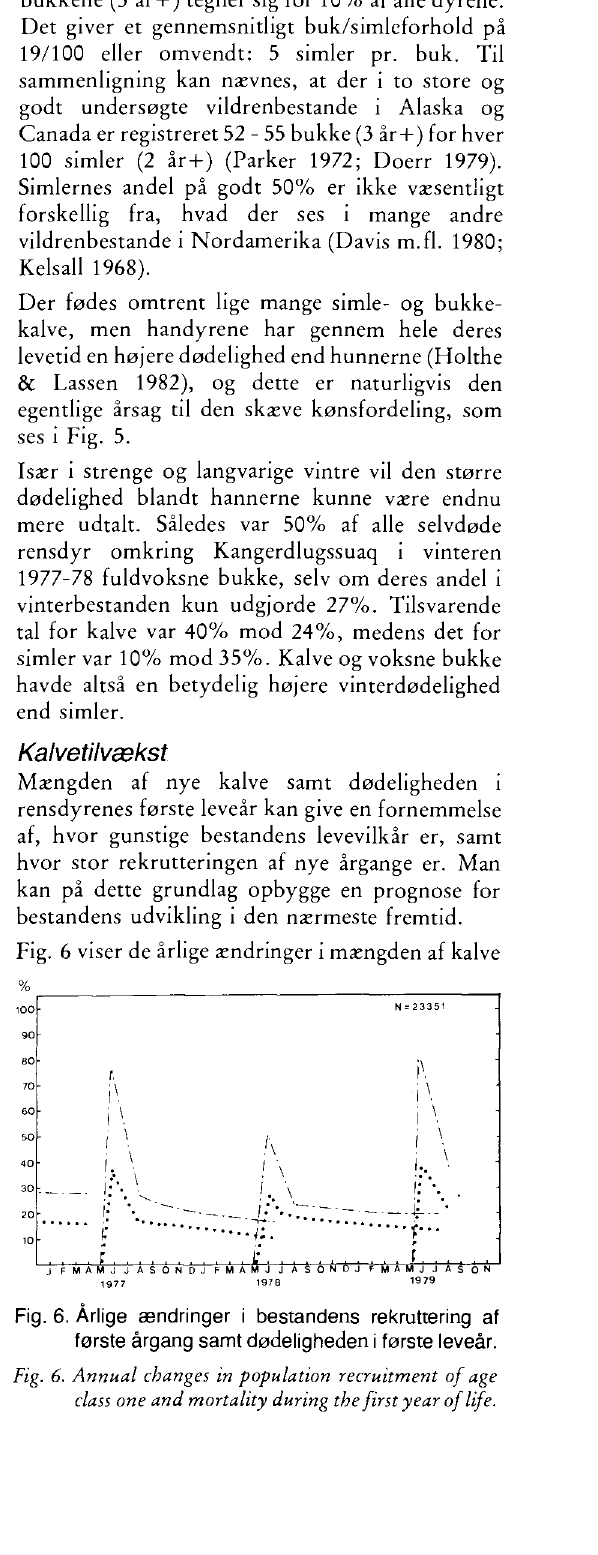
Fig. 6. Årlige ændringer i bestandens rekruttering af første årgang samt dødeligheden i første leveår. Fig. 6. Annual changes in population recruitment of age class one and mortality during the first year of